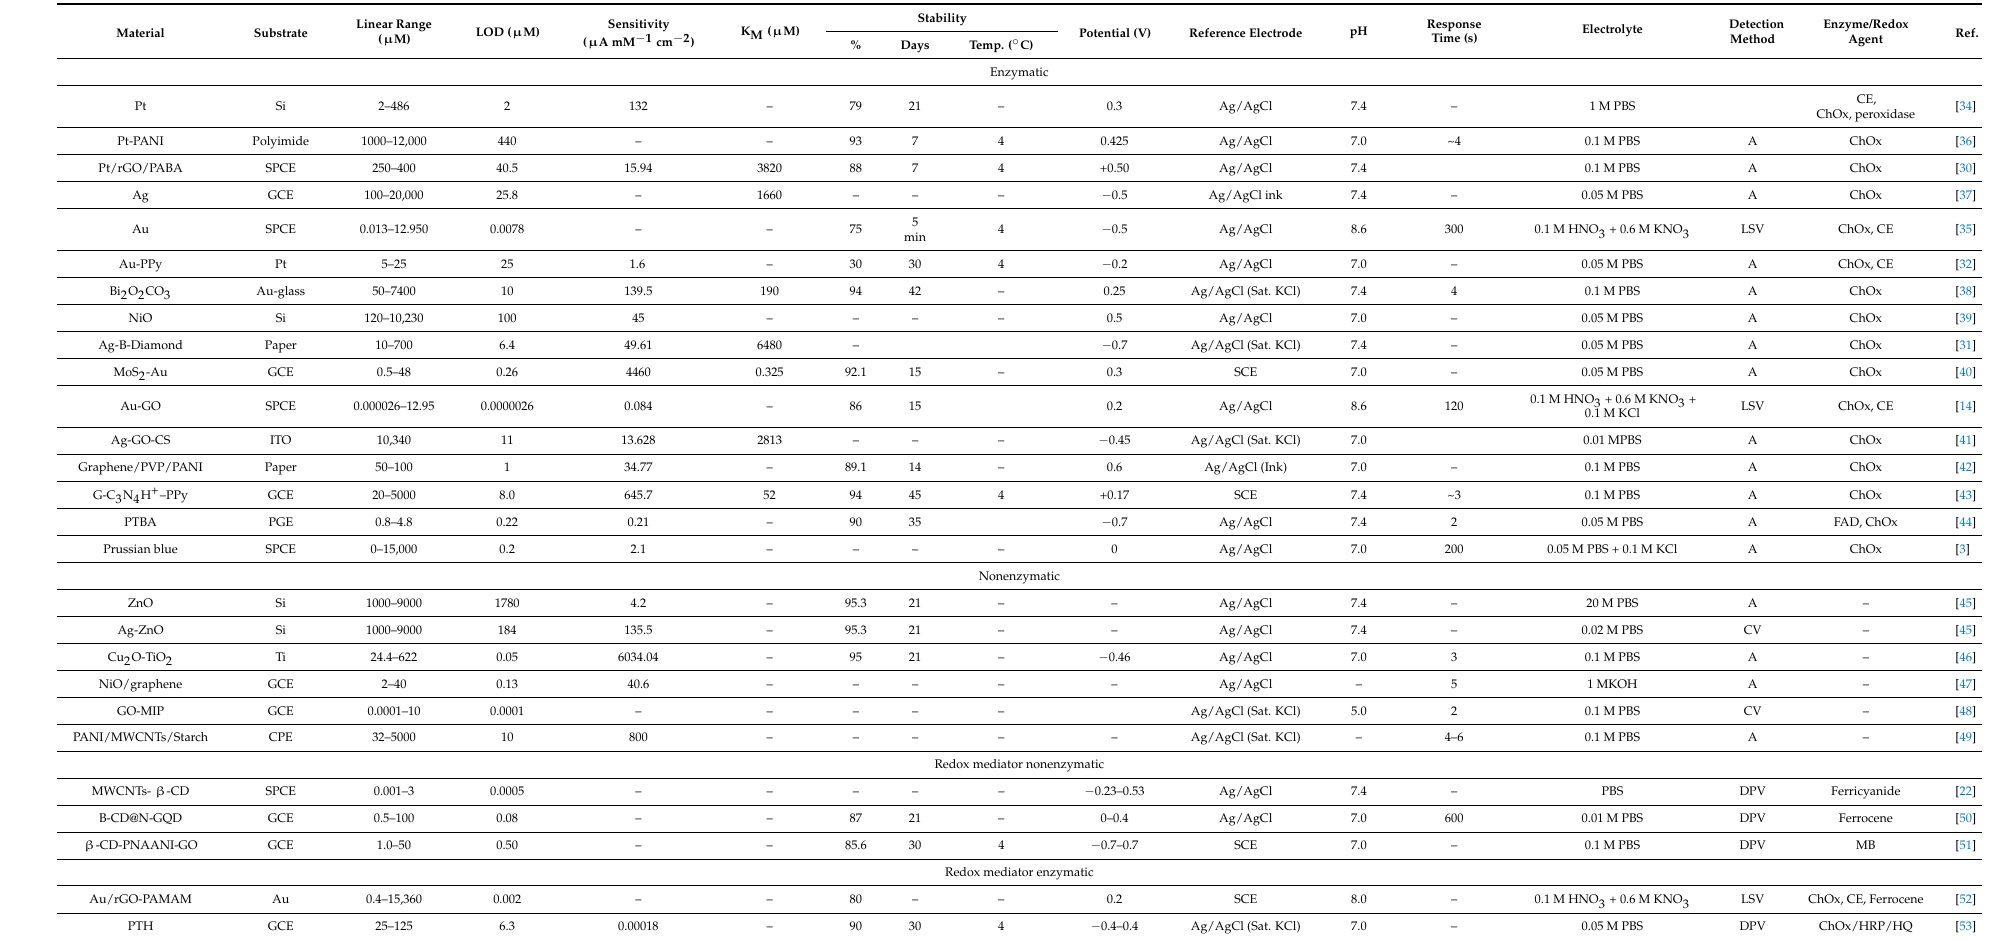
Table 1. Nanomaterials Based Cholesterol